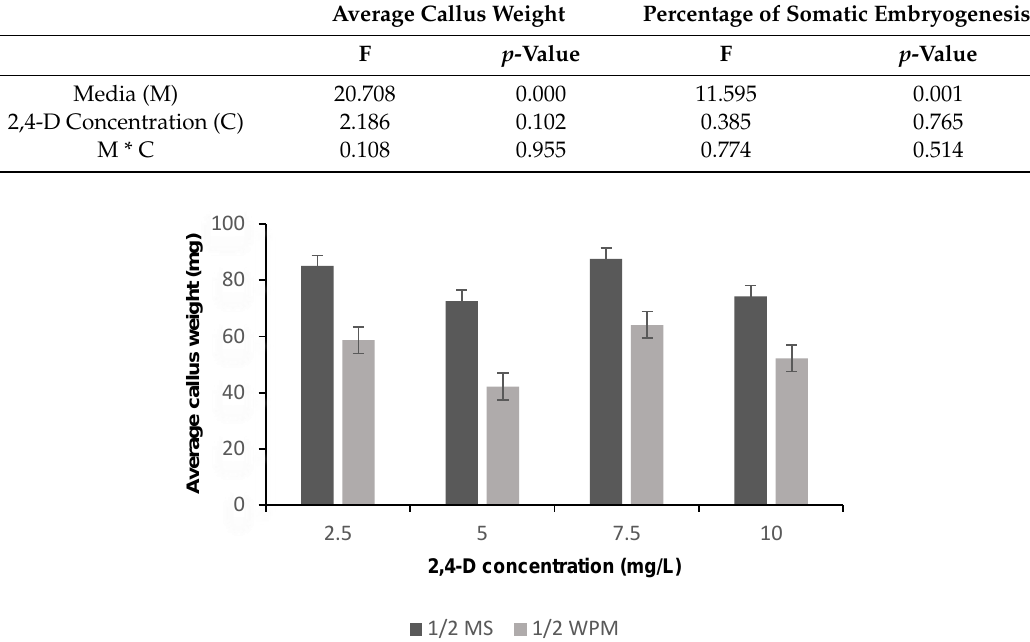
Figure 2. The means of average callus weight (g) on different media supplemented with different 2,4- D concentrations after 6 weeks of culture. MS: Murashige and Skoog; WPM: McCown Woody Plant.